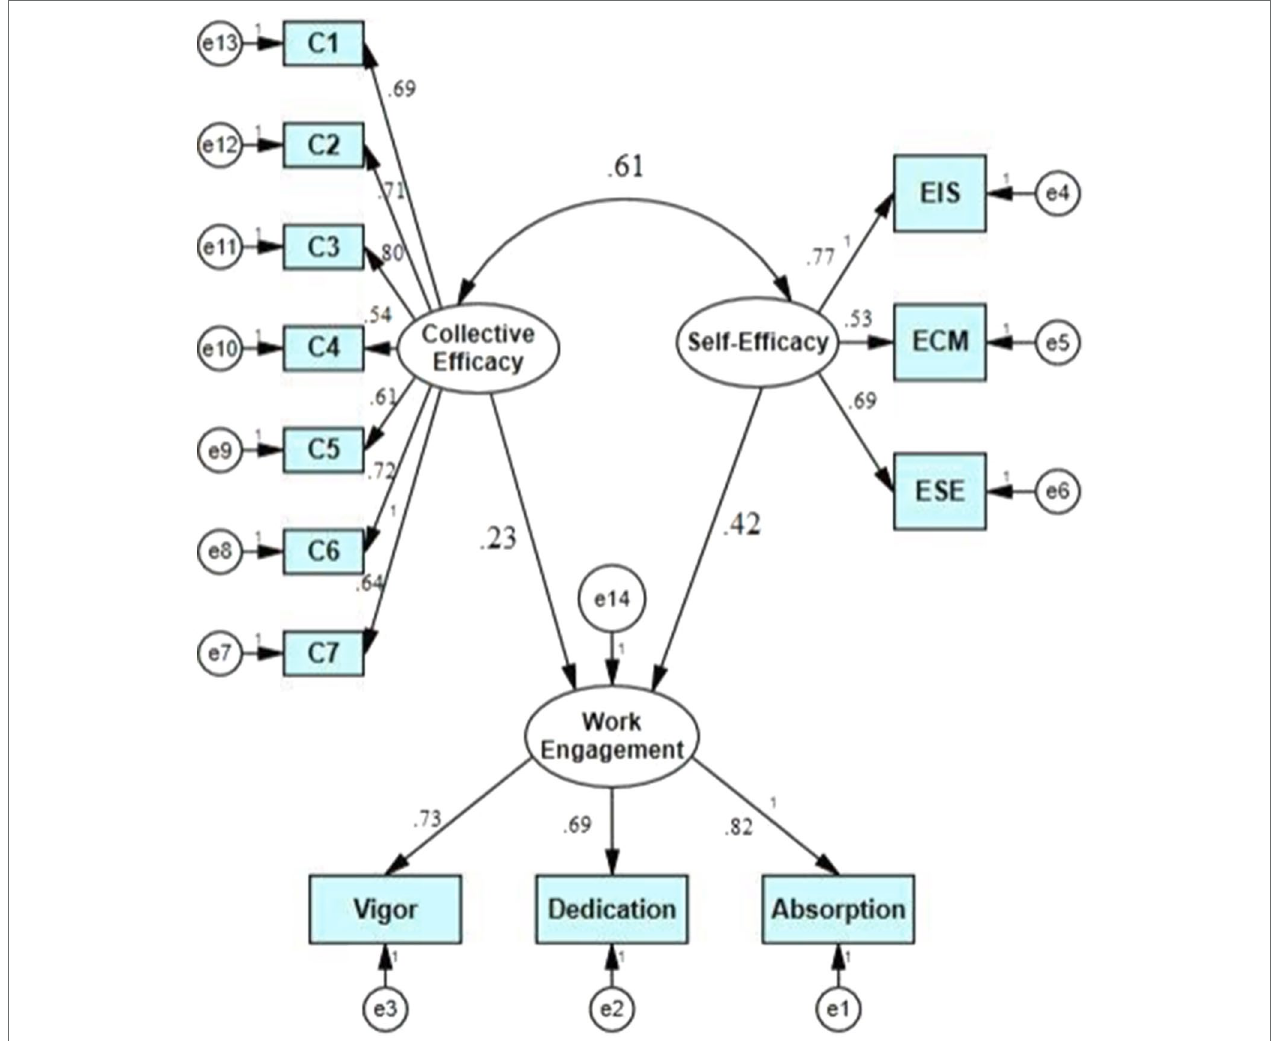
FIGURE 1 | The model of the interplay among teacher collective efficacy (TSE), teacher self-efficacy (TSE), and